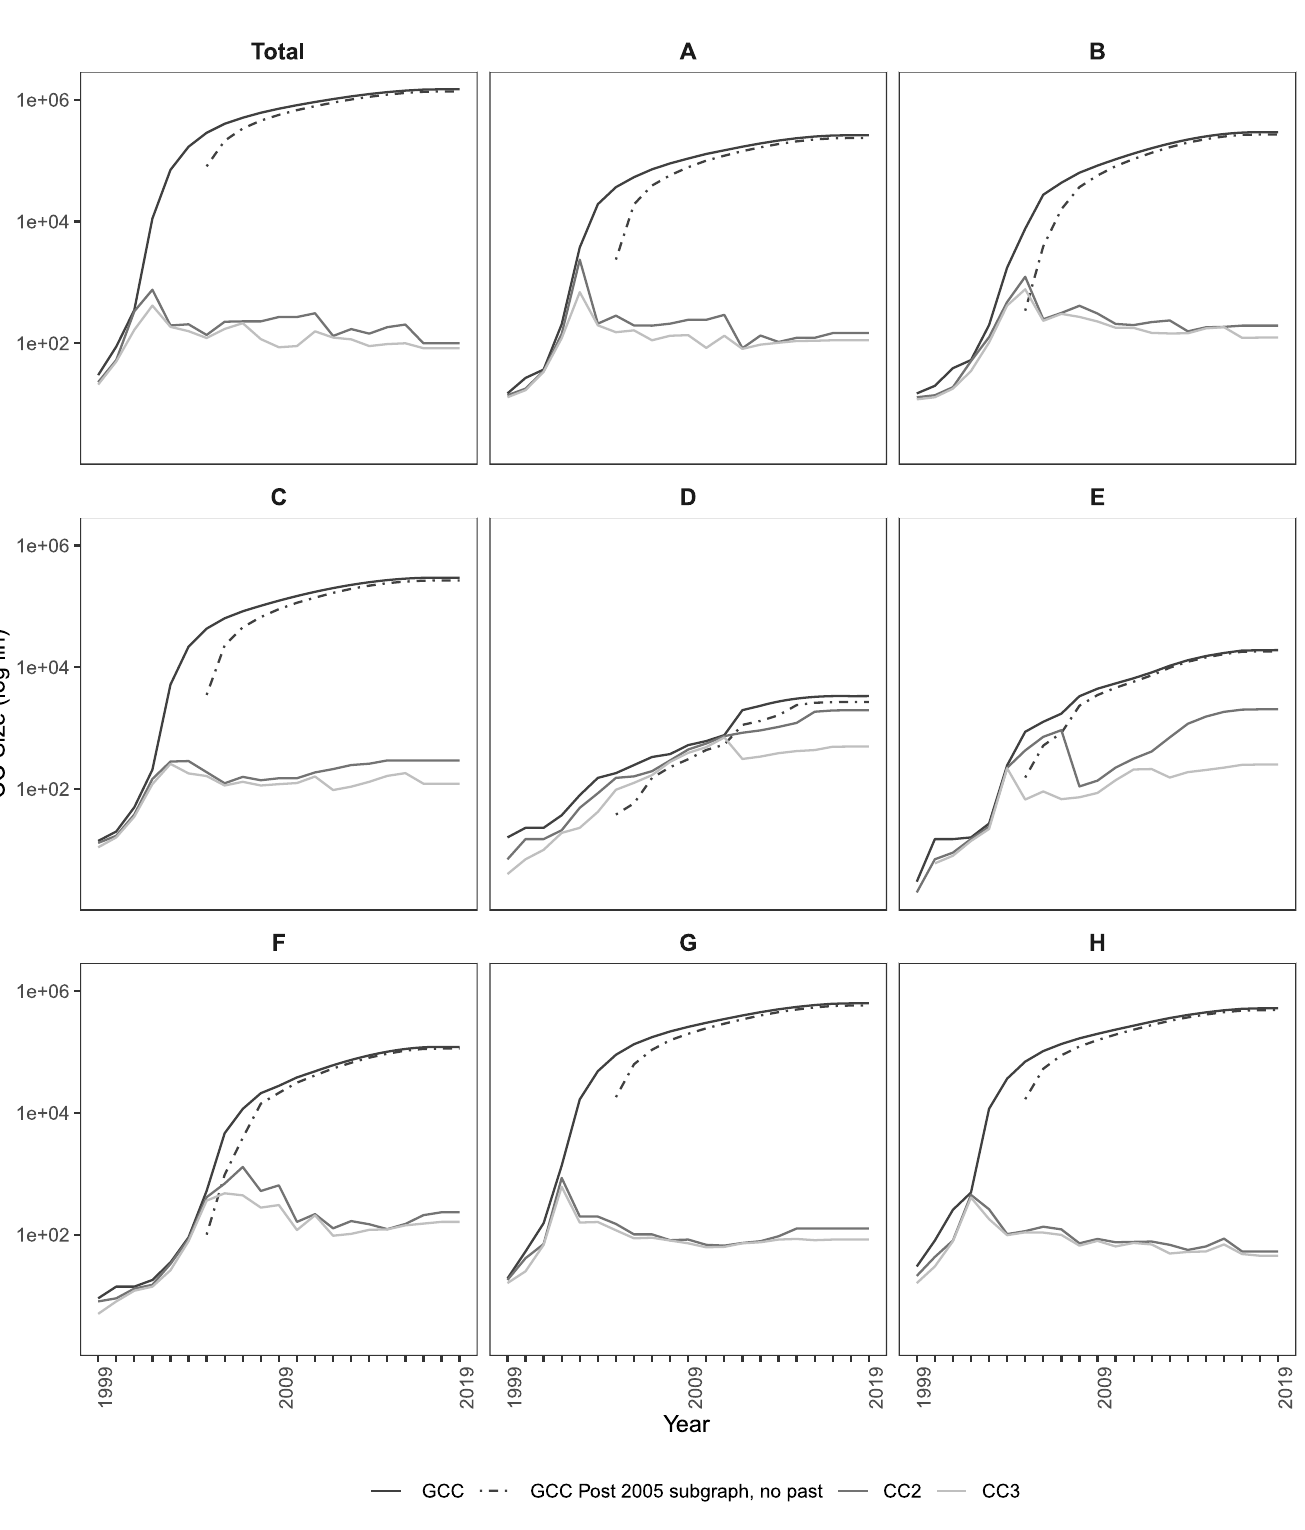
PLOS ONE | https://doi.org/10.1371/journal.pone.0256956 September 2,